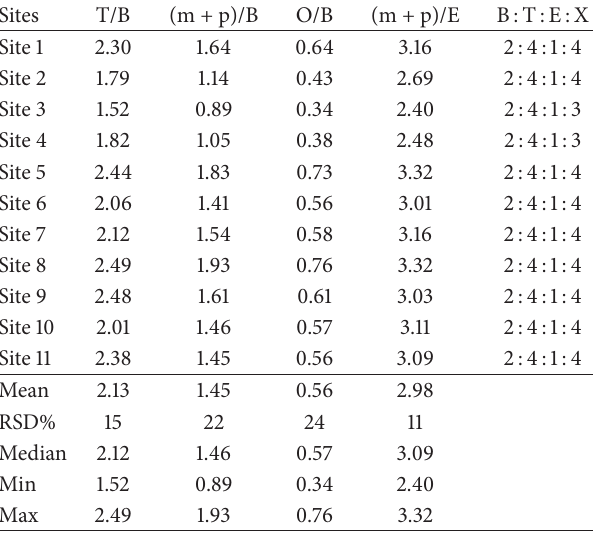
Table 3: Diagnostic ratios between the BTEX